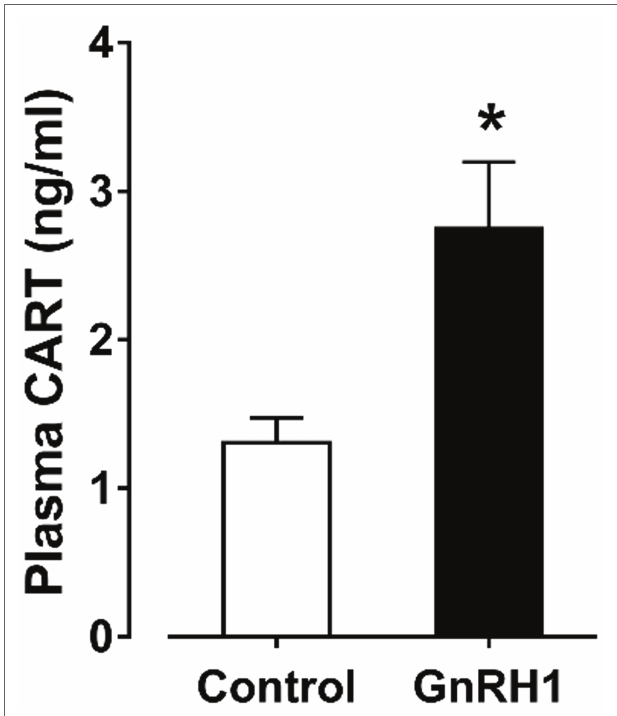
FIGURE 3 | Enzyme-linked immunosorbent assay (ELISA) analyses showed that intraperitoneal administration of GnRH1 (5 μg/chick, 30 min) significantly elevated plasma cocaine- and amphetamine-regulated transcript (CART) peptide levels in vivo . Each data point represents mean ± SEM of seven 19-day-old male individuals ( N = 7). * p < 0.05 vs. saline